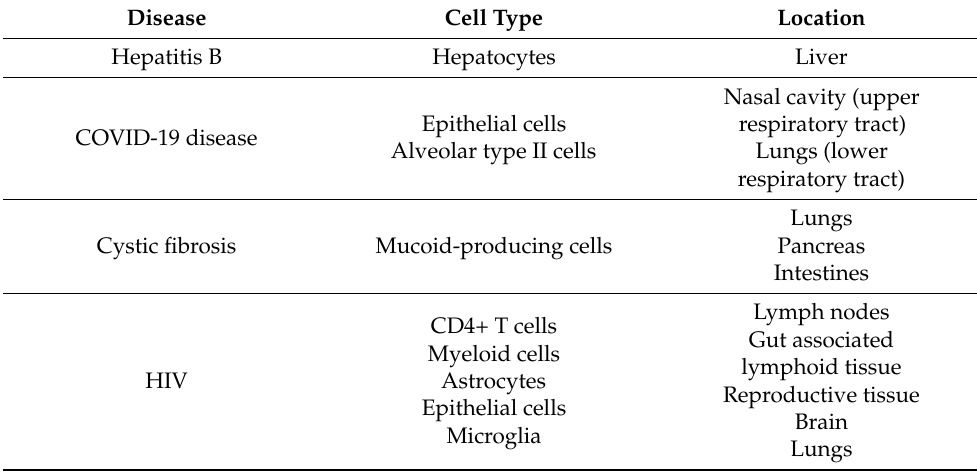
Table 2. Summary of specific disease types to demonstrate the wide range of specific organ and cell targets. There is increasing difficulty of targeting therapeutics for disease treatment when a greater number of affected cell types are